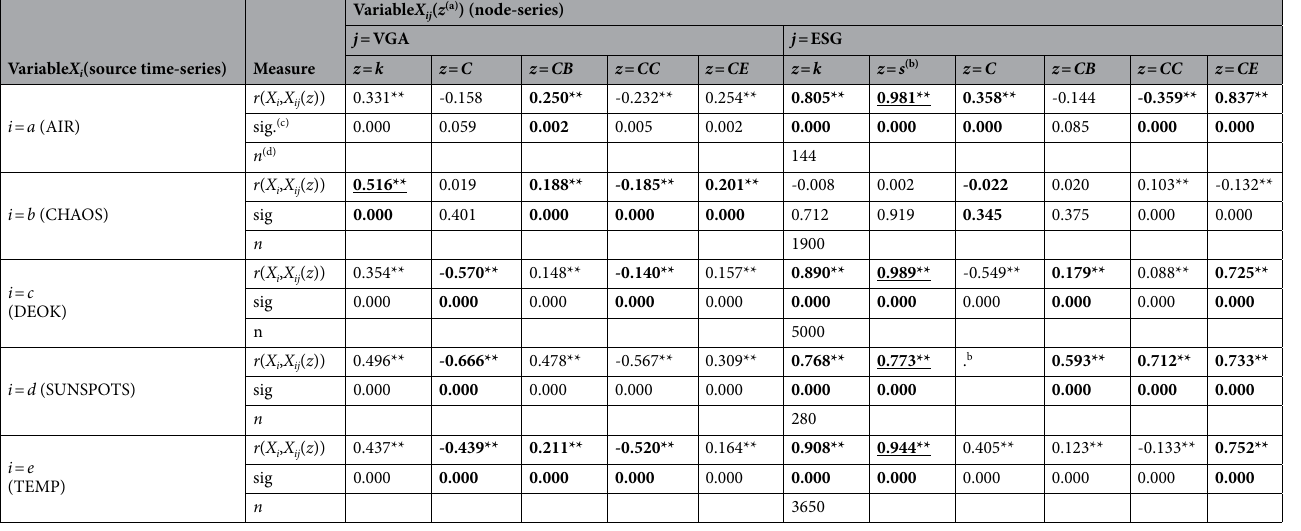
Table 2. Results of the Pearson’s bivariate correlation analysis. a k = node degree, C = clustering coefficient, CC = closeness centrality, CB = betweenness centrality, CE = eigenvector centrality. c. In pairwise consideration, X ESG ( s ) is paired with the X VGA ( k ). c. 2-tailed significance. d. Number of cases. **Correlation is significant at the 0.01 level (2-tailed). Cases shown in bold indicate maximum coefficients (in absolute terms)